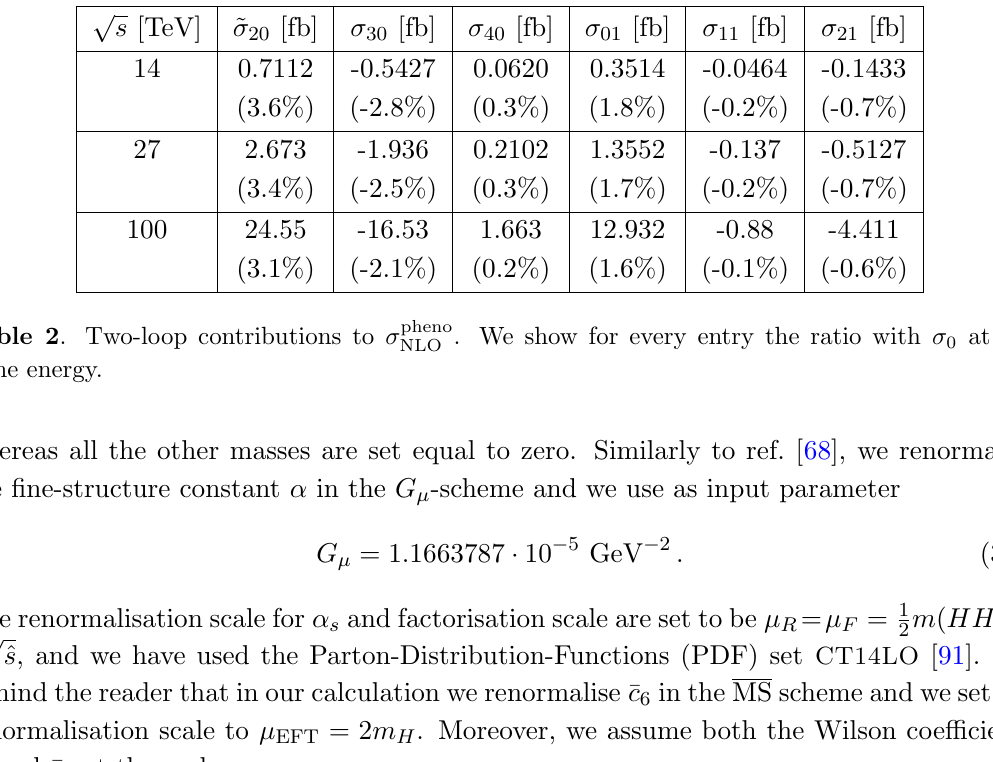
. We show for every entry the ratio with (cid:27) 0 at the NLO